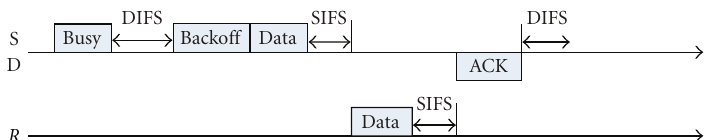
Figure 1: CoopMAC (virtual-hop relay